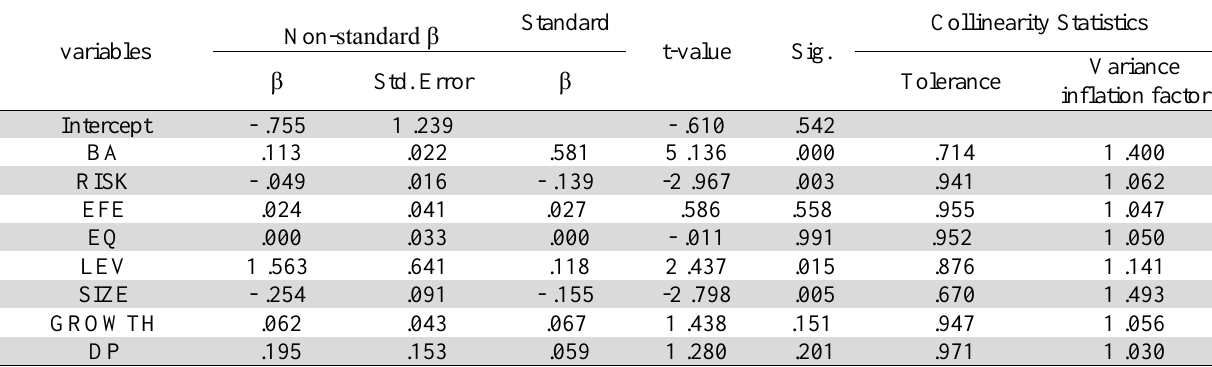
The summary of regression technique on Eq. (2) variables